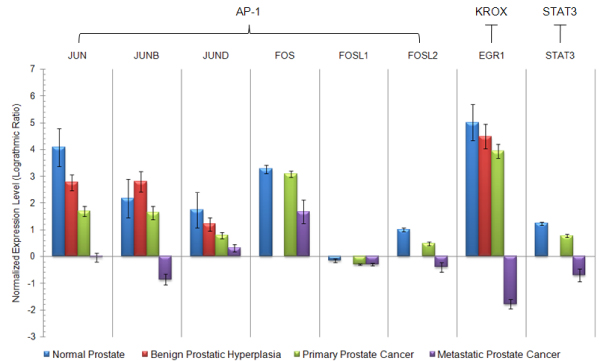
Expression pattern of predicted transcription factors in different stages of prostate abnormality. Expression profiles of JUN, JUNB, JUND, EGR are from the same study in Oncomine database, which classifies prostate abnormality into four stages, normal prostate, benign prostatic hyperplasia, primary prostate cancer, and metastatic prostate cancer. FOS, FOSL1, FOSL2, STAT3 are from other two studies both of which include three subtypes, including normal prostate, and primary and metastatic prostate cancer. JUN, JUNB, JUND, FOS, FOSL1, FOSL2 bind to AP-1 binding site, EGR1 binds to KROX binding site, STAT3 binds to STAT3 binding site.